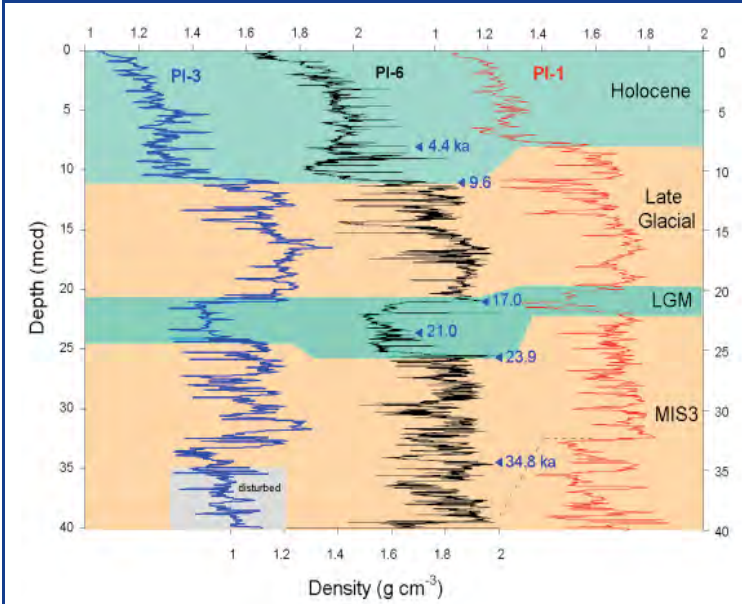
Figure 5. Correlation of composite density records for upper 40 m of Sites PI-3 (water depth =100 m), PI-6 (water depth = 71 m), and PI-1 (water depth =65 m) from Lake Petén Itzá’s central basin. Calibrated radiocarbon dates on terrestrial organic matter are indicated from Site PI-6. LGM = Last Glacial Maximum; MIS3 = Marine Isotope Stage